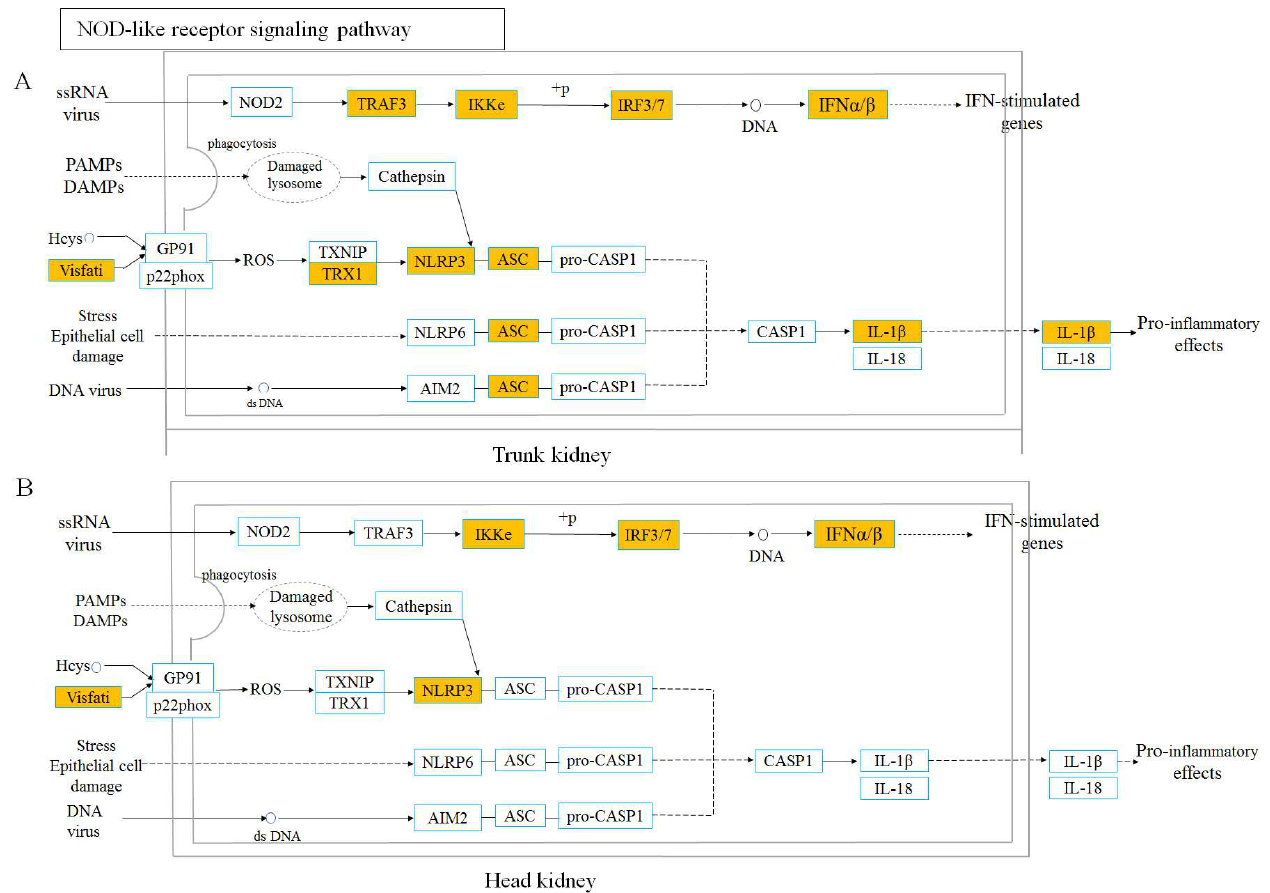
Figure 5. TOLL-like receptor signaling pathway was analyzed and simplified from KEGG. Genes marked in orange represent DEGs in RNA-seq.